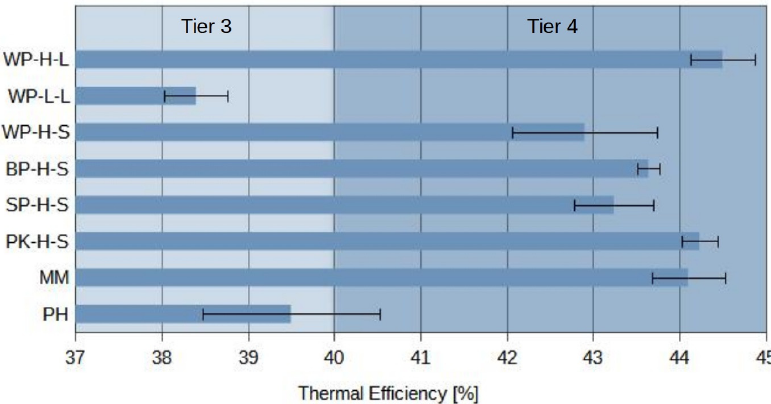
Figure 4. Thermal efficiency of the Apeli stove in comparison with the Philips HD4012 [10] and Mimi Figure 4. Thermal e ffi ciency of the Apeli stove in comparison with the Philips HD4012 [10] and Moto [10] stoves at high power output. Confidence intervals (90%), as specified in ISO 19867-1 [16], Mimi Moto [10] stoves at high power output. Con fi dence intervals (90%), as speci fi ed in ISO 19867- using pooled standard deviations are represented by the error bars. 1 [16], using pooled standard deviations are represented by the error bars.